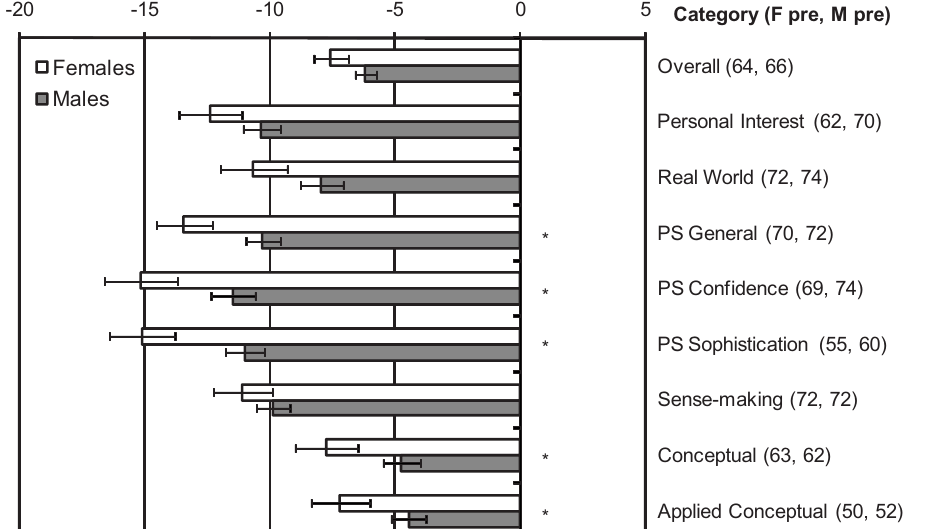
FIG. 3. Average shifts (cid:1) post −pre (cid:2) for males and females on each of the CLASS categories. Note that all shifts are negative, meaning both male and female students shift toward less expert- like attitudes and beliefs about physics. The asterisk (cid:1) * (cid:2) indicates that the difference in shifts for males and females is significant (cid:1) p (cid:3) 0.05 (cid:2) . Values in parentheses are female and male average pre- test scores. Females have more negative shifts in each category than